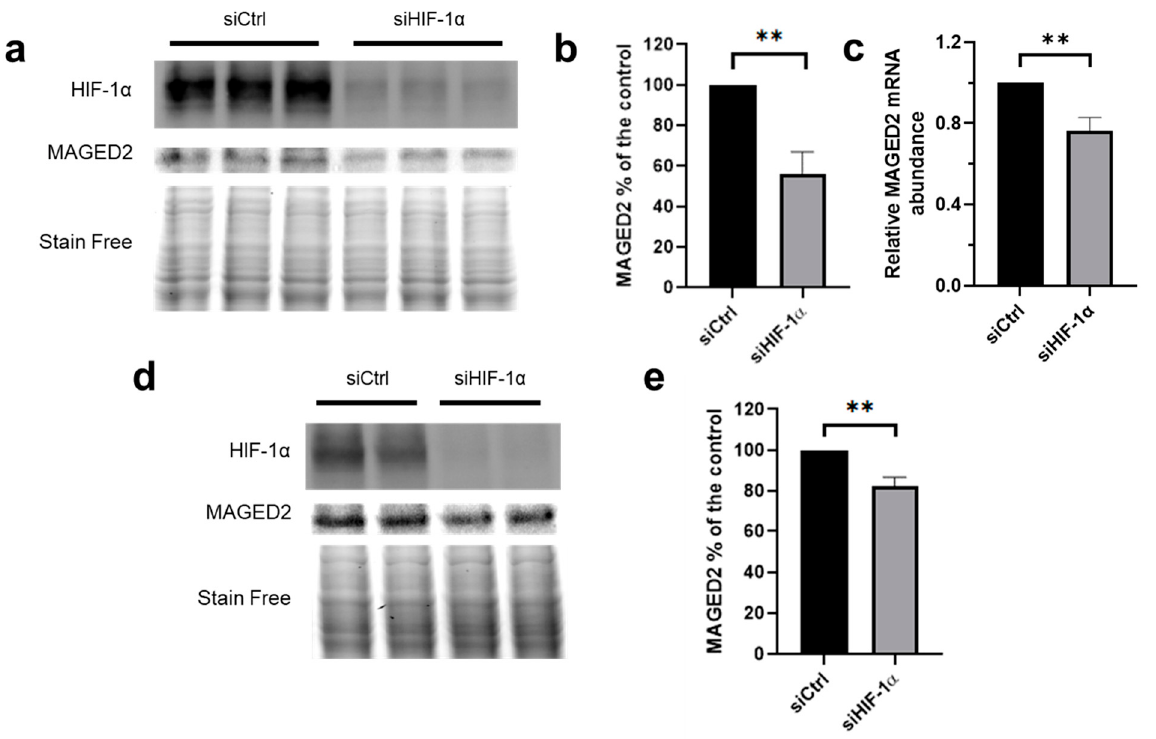
Figure 6. HIF-1 α knockdown reduces MAGED2 expression under hypoxia. HeLa ( a , c ) and HEK293 ( d ) cells were transfected with control or HIF-1 α siRNA. cells were treated with 300 µM CoCl 2 for 14–16 h: ( a , d ) Total cell lysates were separated by SDS-PAGE and probed by anti-HIF-1 α and MAGED2 antibodies. ( b , e ) densitometric analysis of HIF-1 α immunoblot presented in ( a , d ), respectively. ( c ) HeLa cells were exposed to physical hypoxia for 14 h. Total RNA was extracted, and the relative mRNA amount of MAGED2 was determined by qRT-PCR. Statistical significance was determined by unpaired two-sided Student’s t -test ( b , c , d ). All Western blots shown are from the same experiment, which is a representative example of three independent experiments. Bar graphs show mean ± SEM. ** p ≤ 0.01.